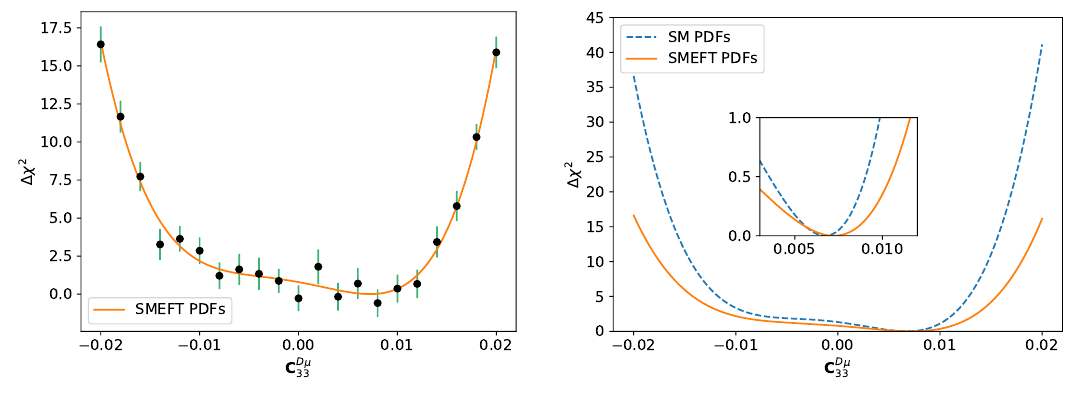
Figure 18 . Left: the values of ∆ χ 2 obtained for the SMEFT PDFs as a function of C Dµ the fits including the HL-LHC pseudo-data, together with the corresponding quartic polynomial fit. Right: comparison of the polynomial fit obtained with SMEFT PDFs and displayed in the left panel with its counterpart based on SM